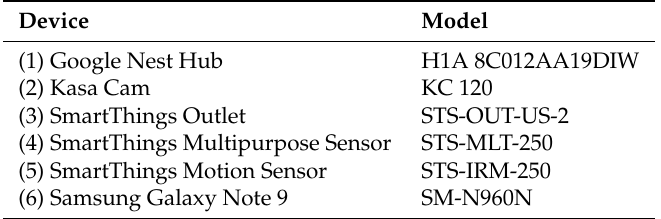
Table 2. Test devices employed in the experimental environment.